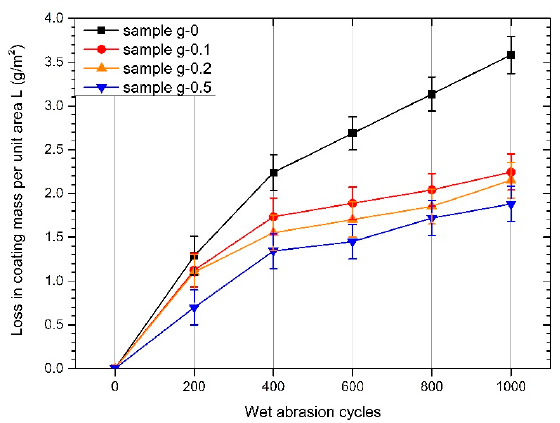
Figure 12. Loss in coatings mass per unit area, as a function of the abrasion cycles number.